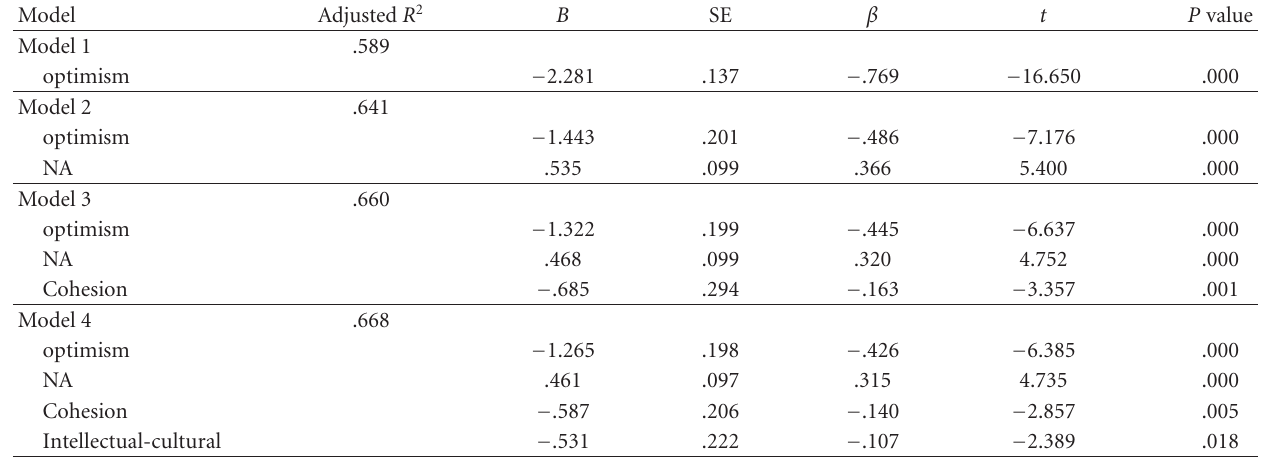
Table 3: Hierarchical regression analysis of significant factors predicting